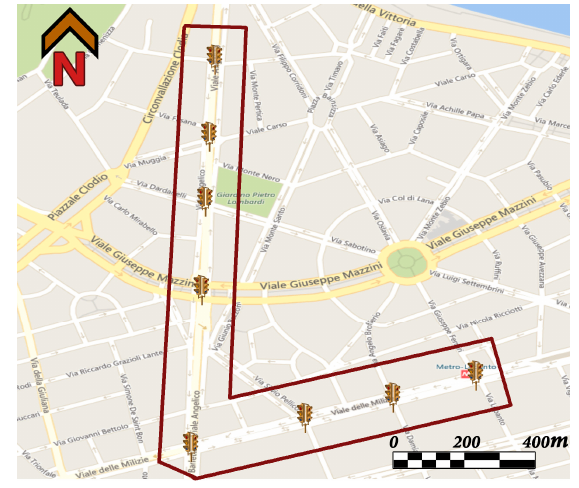
Figure 8. Study area on Google Maps.